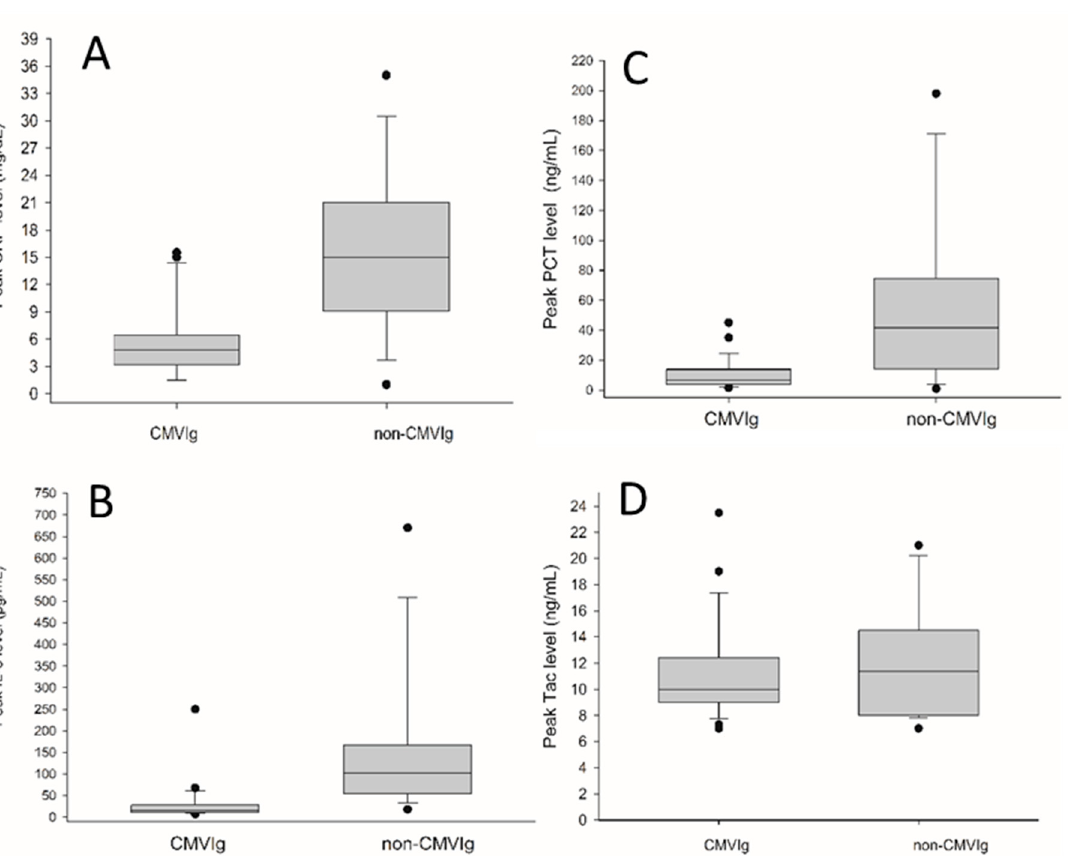
Figure 1. Post-LT peak serum levels of CRP ( A ), p < 0.001; IL-6 ( B ), p < 0.001 and PCT ( C ) p = 0.017 were all significantly lower following CMVIg treatment, whereas peak Tac levels ( D ) p = 0.336 were comparable.